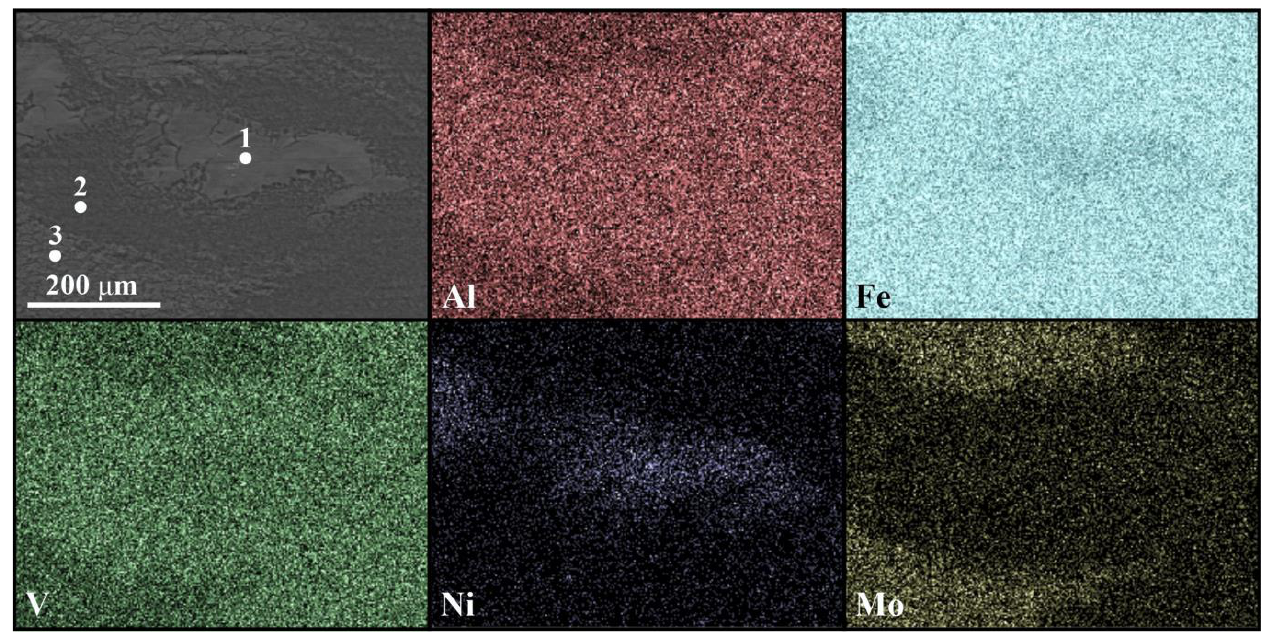
Figure 20. SEM image of the joint section and EDX maps of the tool and titanium alloy elements in the Ti-4Al-3Mo-1V joint. Table 8. Results of the chemical composition analysis performed on the joint section.